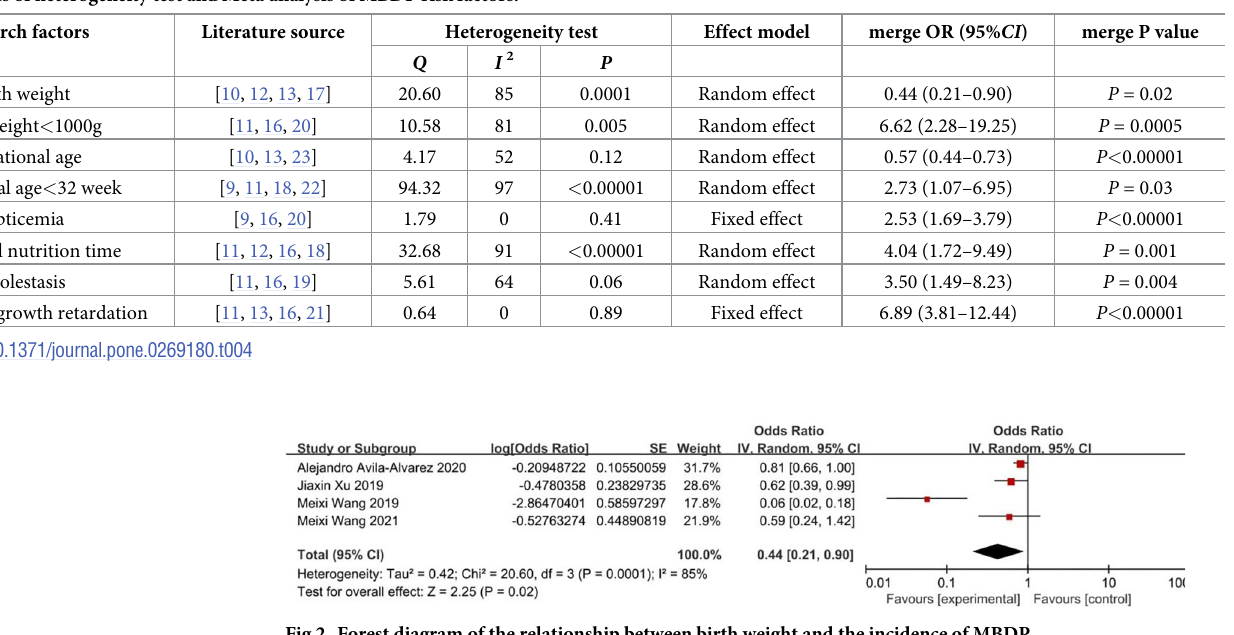
Table 4. Results of heterogeneity test and Meta analysis of MBDP risk factors.